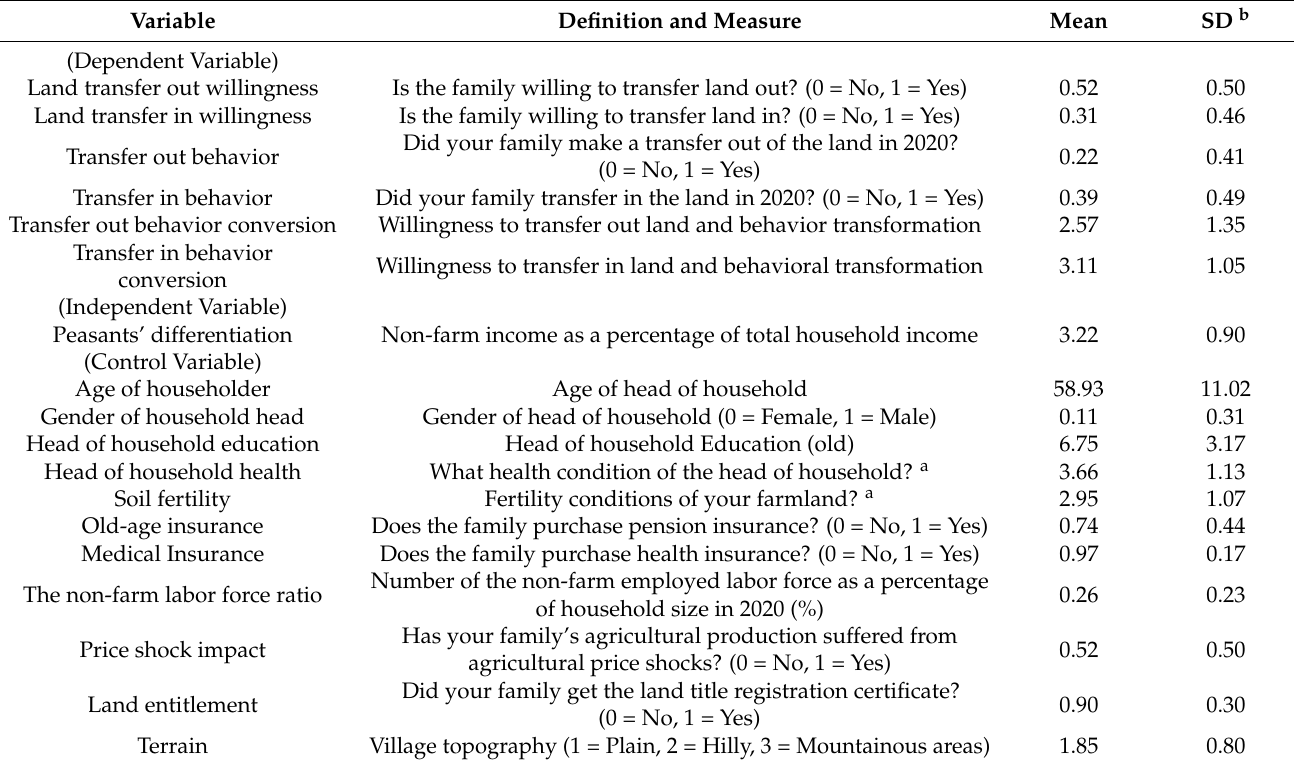
Table 1. Definition and descriptive statistics of the variables in the